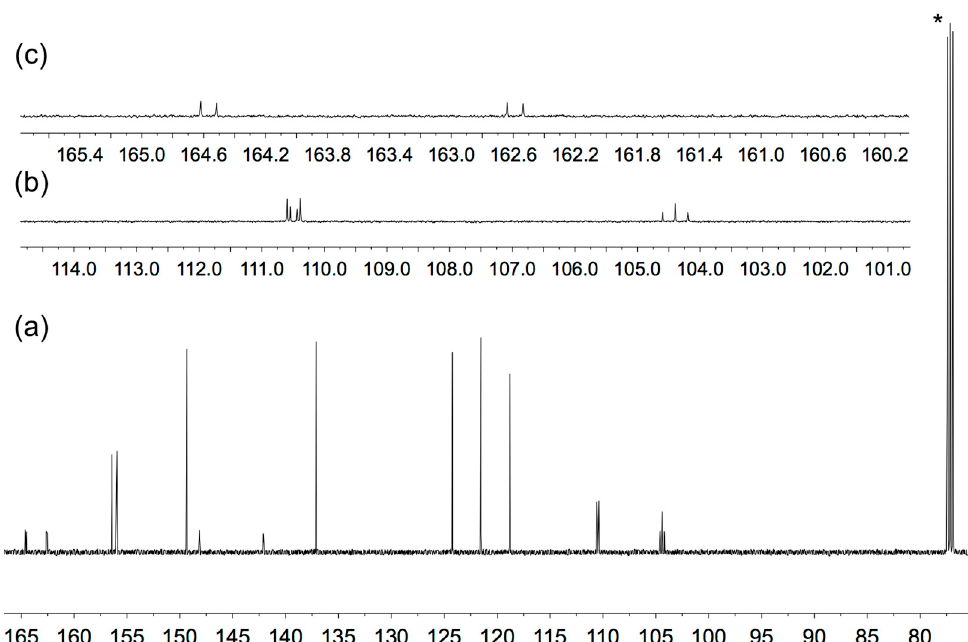
Figure 3. 13 C{ 1 H} NMR spectrum (126 MHz, CDCl 3 ) of compound 4 . ( a ) Full spectrum with solvent